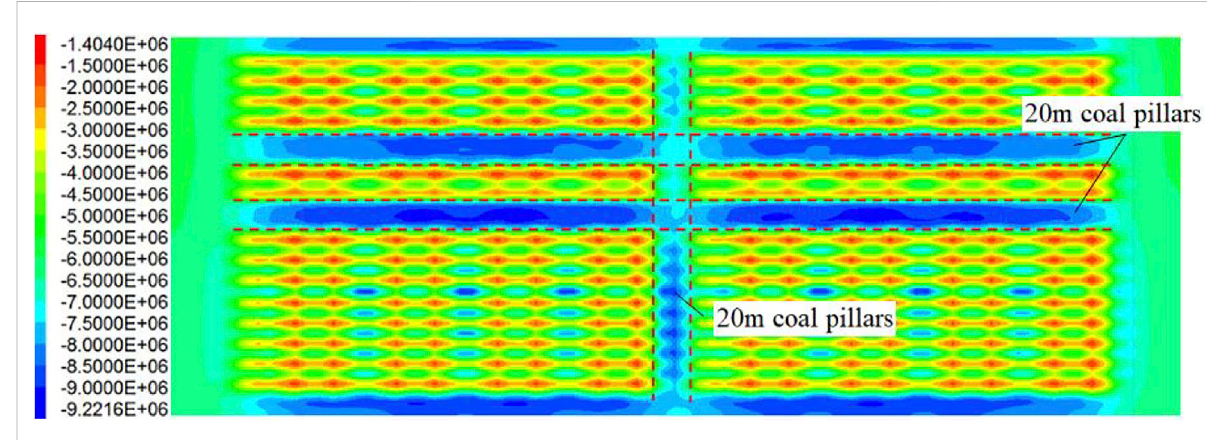
FIGURE 7 Vertical stress distribution of strata at 0 m on top of 3# coal seam (Pa).